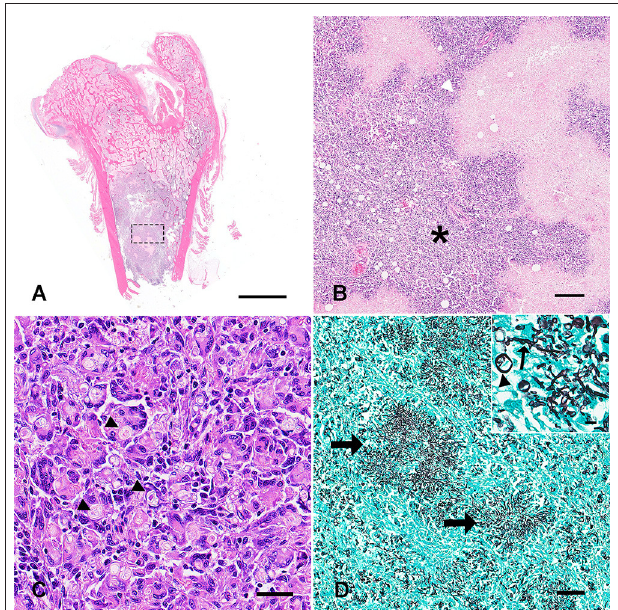
FIGURE 2 | Photomicrographs of sections of the femur (A,B) and lymph node (C,D) obtained from the dog in Figure 1 . (A) The marrow space was largely effaced and replaced by multifocal to coalescing granulomatous cellular infiltrate (H&E; bar = 9mm). (B) Higher magnification of the granulomas from A (dashed square). The granulomas were centered on extensive areas of lytic necrosis (white arrowhead) and dissected by myriad macrophages and epithelioid macrophages, numerous multinucleated giant cells with up to 10 nuclei, and moderate numbers of lymphocytes, plasma cells, and lesser neutrophils (asterisk; H&E; bar = 200 µ m). (C) The lymph node architecture was completely replaced by similar cellular infiltrates. Numerous intralesional, intracellular and extracellular, negatively stained, non-pigmented, septated with parallel walls, acute angle branching hyphae measuring 3–6 µ m in width with polar bulbous projections measuring 7–13 µ m in width (arrowheads; H&E; bar = 50 µ m). (D) Hyphal mats were positively stained with Gomori methenamine-silver stain (arrows) (bar = 100 µ m). Occasionally, yeast forms measuring 7–15 µ m were present (arrowhead) among hyphae (arrow) (inset; bar = 20 µ